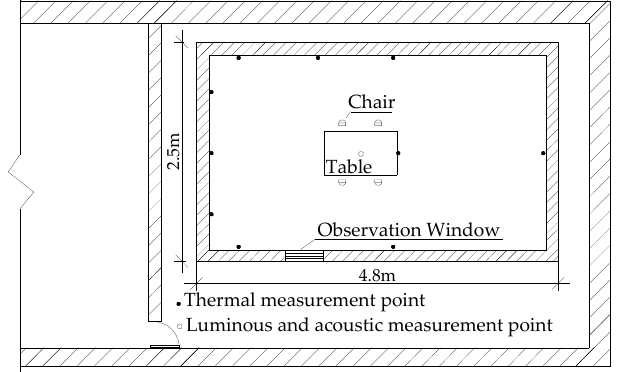
Figure 1. The structure of simulation chamber.